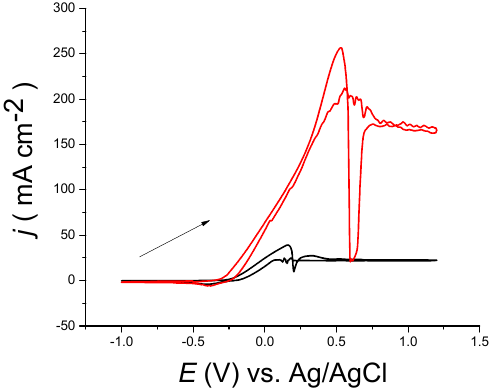
Figure 5. Cyclic voltammograms of bulk Cu disc in choline chloride-based IL at 20 °C (black line) and 70 °C (red line) at 5 mV·s − 1 .